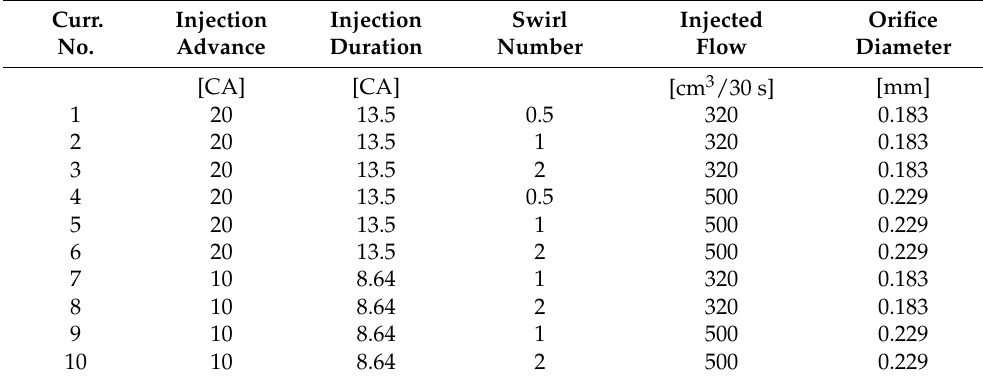
Table 3. The engine’s parameters in the testing points for US-13 Mode testing cycle for the combustion chamber 1 (ovoid shape).